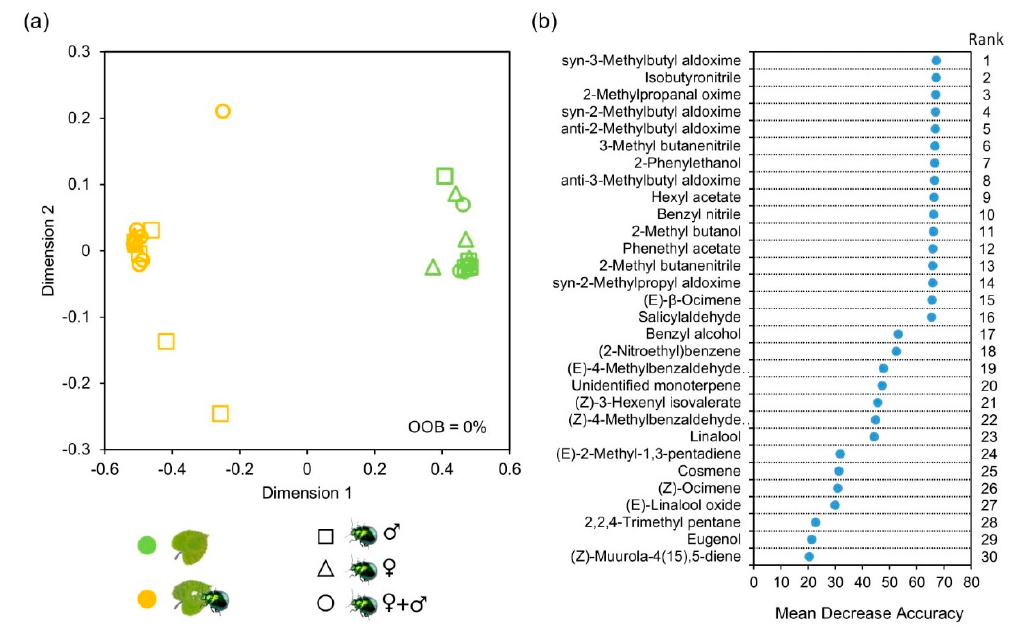
Figure 4. Random Forest (RF) classification analysis of volatile profiles from undamaged and damaged hybrid aspen plants. Seedlings were infested (orange symbols) for approximately 42 hours by female adults of leaf beetle ( ♀ ), or male adults ( ♂ ), or a mixture of females and males ( ♀ + ♂ ), with their respective control left uninfested (green symbols). Volatiles were collected following insect olfactory bioassays. ( a ) Multidimensional scaling plot of RF model classifying volatile bouquets released from undamaged and damaged plants, independent of gender identity of the attacking leaf beetles. During 100000 replicated tree constructions samples were always assigned correctly, with the out-of-bag (OOB) error being 0%. ( b ) Importance ranking of volatile compounds contributing to separation between undamaged and damaged plants based on mean decrease in accuracy (MDA) following RF analysis.